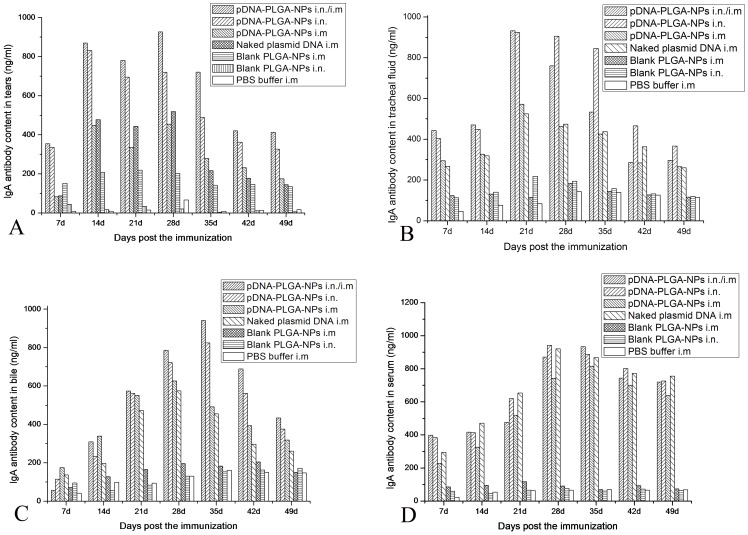
IgA antibody content in tears of SPF chickens immunized with PBS (i.m.), blank PLGA-NPs (i.m.), blank PLGA-NPs (i.n.), and the naked plasmid DNA (i.m.), pFNDV-PLGA-NPs (i.m.), pFNDV-PLGA-NPs (i.n.) or pFNDV-PLGA-NPs (i.m./i.n.).(A) IgA antibody content in tears; (B) IgA antibody content in tracheal fluid; (C) IgA antibody content in bile; (D) IgA antibody content in serum. IgA antibody content was presented as mean ± SD of five experiments. Data with different small letters show significant difference (p<0.05).